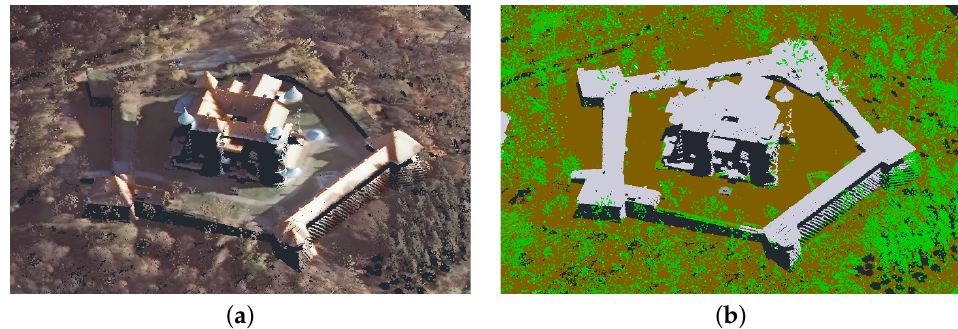
Figure 13. ISOK point cloud: scanning colors ( a ); class colors ( b ).